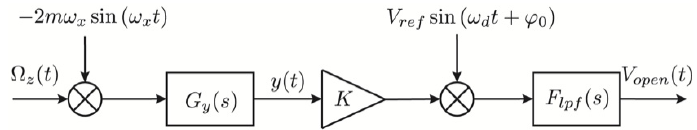
Figure 1. Schematic diagram of gyroscope open-loop detection.